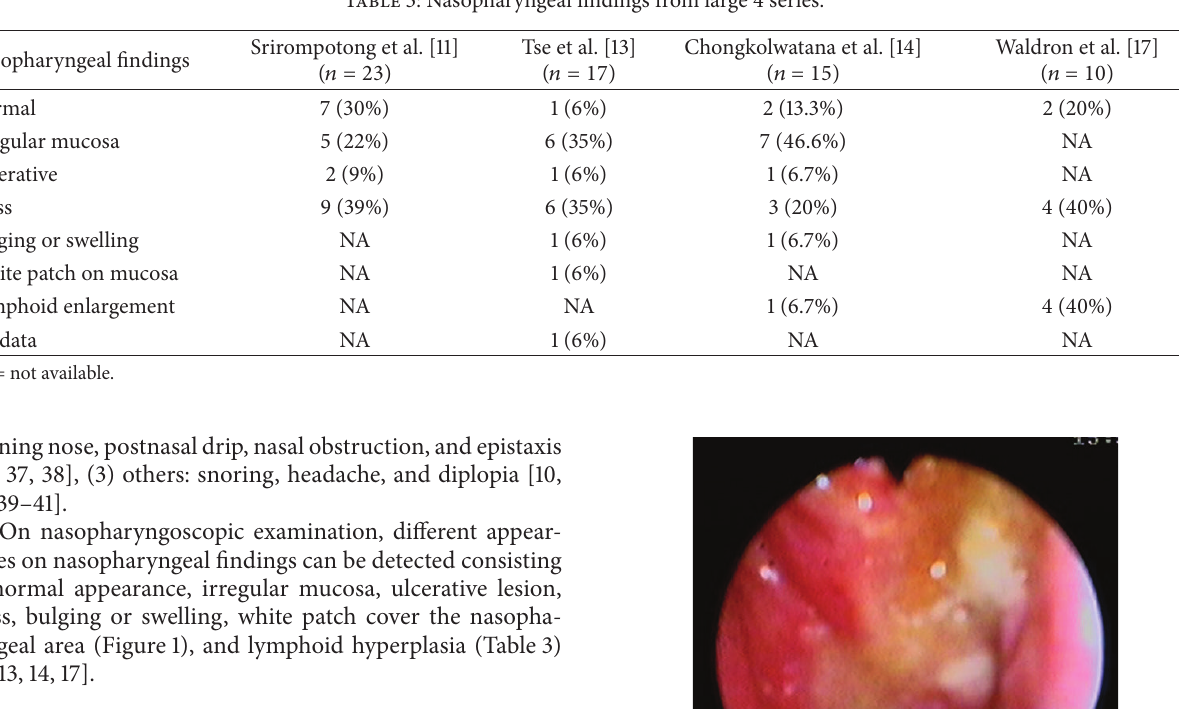
Table 3: Nasopharyngeal findings from large 4 series.